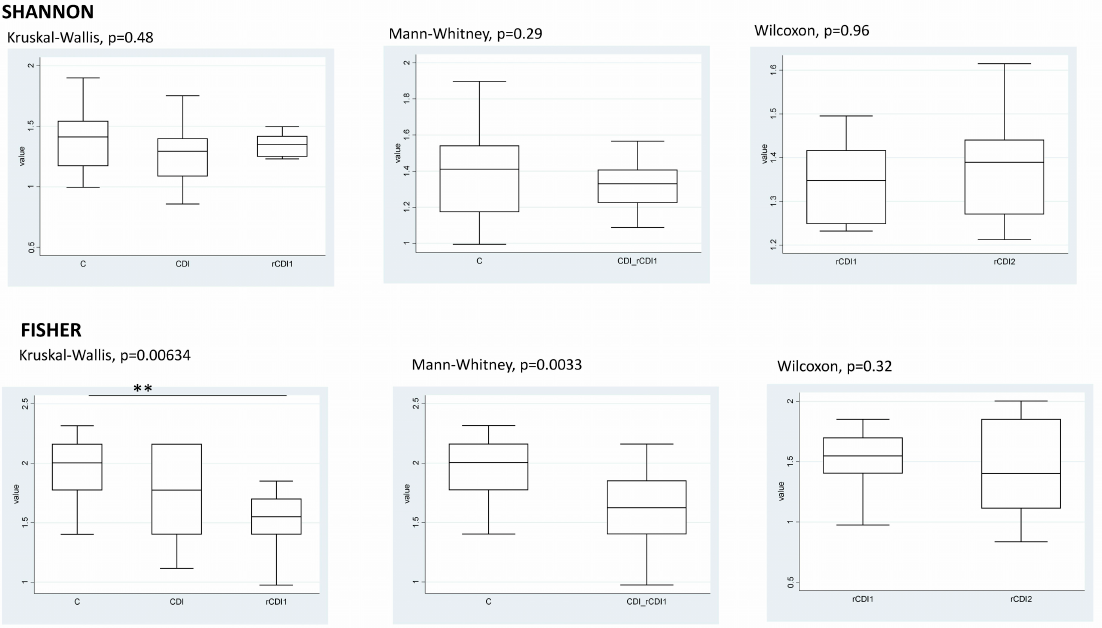
Figure 3. α -diversity. Overall comparison of microbiota structure. Observed richness, abundance coverage estimator (ACE), Shannon and Fisher indices are presented at the taxonomic level of classes. Significant (** p < 0.01) comparisons between patient categories are indicated over the boxplots. Abbreviations for patient cohorts: C = non-infected controls; CDI = non-recurrent C. difficile infection; rCDI1 = recurrent C. difficile infection, first episode; rCDI2 = recurrent C. difficile infection, second episode.